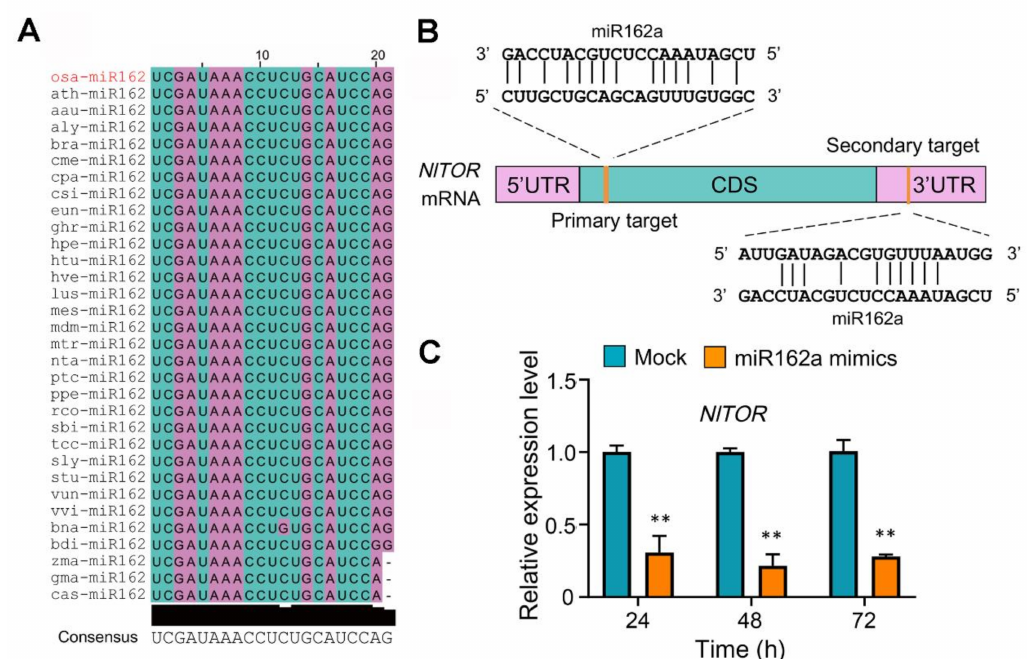
Figure 1. The NlTOR gene of BPH is a target of rice osa-miR162a. ( A ) Sequence alignment indicates that miR162 is highly conserved across 32 plant species. The listed plant miR162 sequences were obtained from the miRBase database. ( B ) Putative target sites of osa-miR162 in NlTOR . The target sites are indicated by orange sticks. CDS, coding sequence; UTR, untranslated region. ( C ) NlTOR expression decreases in BPH female adults after injection with osa-miR162a mimics. The expression levels were quantified by RT-qPCR and the data are presented as mean ± SEM of three biological replicates ( n = 3). The expression levels of NlTOR after injection with negative control miRNA mimics at different time points were normalized as 1. ** p < 0.01 (student’s t